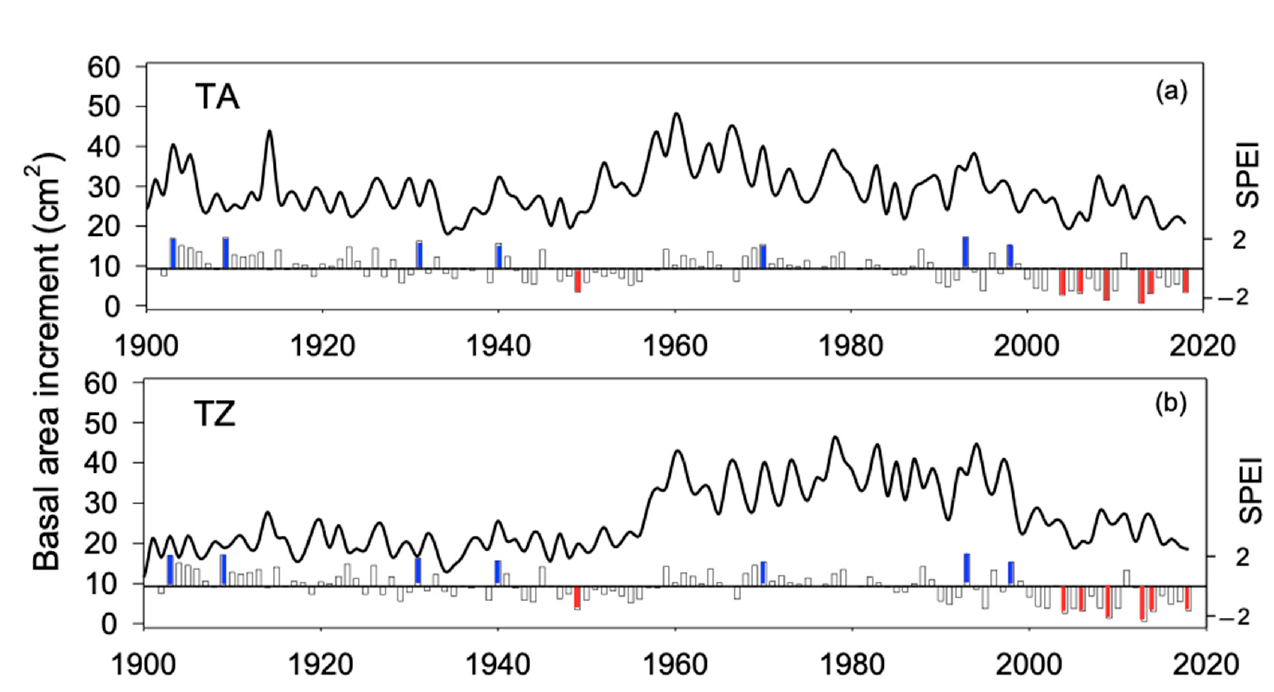
Figure 2. Growth pattern estimated as the basal area increments of tree rings obtained in Abies marocana for Talassemtane, TA ( a ) and Tazaot, TZ ( b ) over the period 1900–2020. Lines represent the mean. Bottom bars indicate the summer SPEI, where extreme moist (blue) and drought (red) events are highlighted .